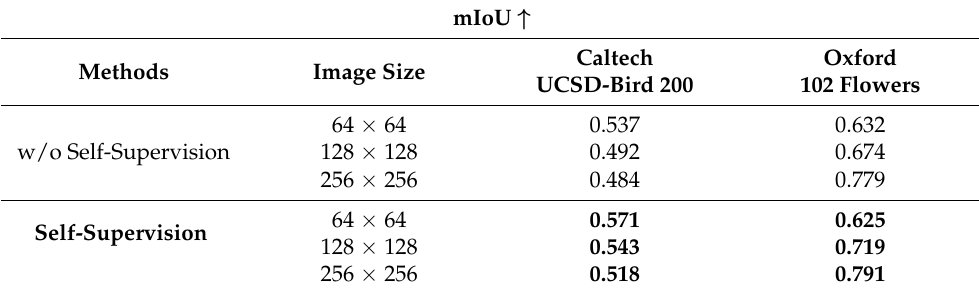
Table 3. mIOU comparison of the proposed method with the baseline CPGAN model.